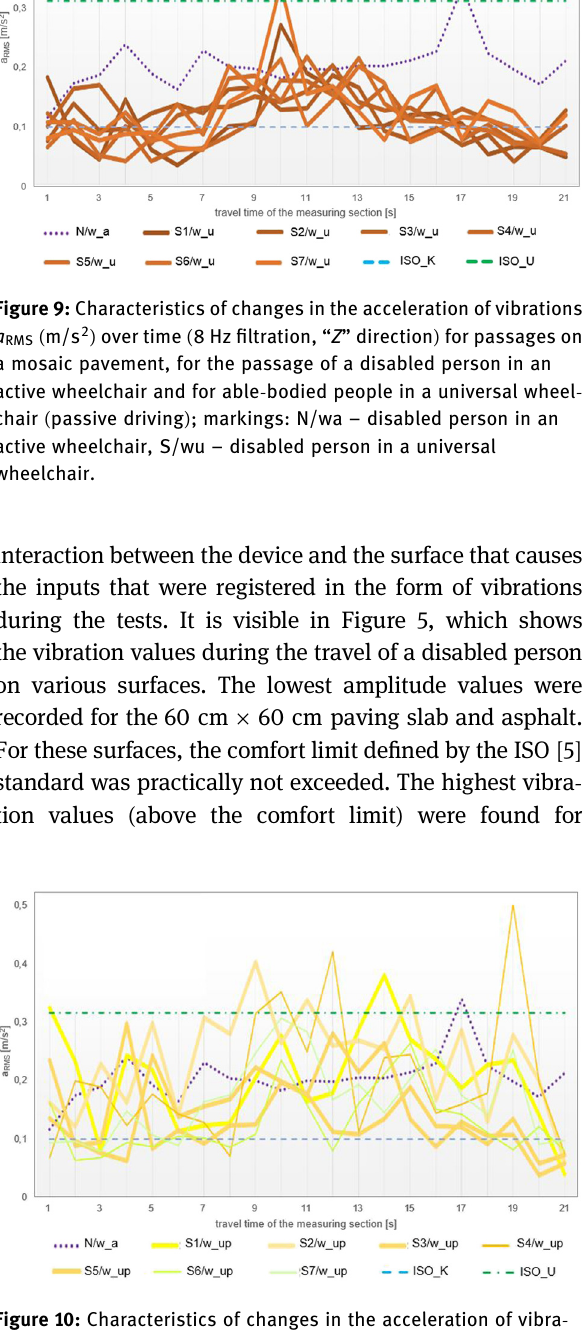
Figure 10: Characteristics of changes in the acceleration of vibra - tions a RMS ( m/s 2 ) over time ( 8 Hz fi ltration, “ Z ” direction ) for pas